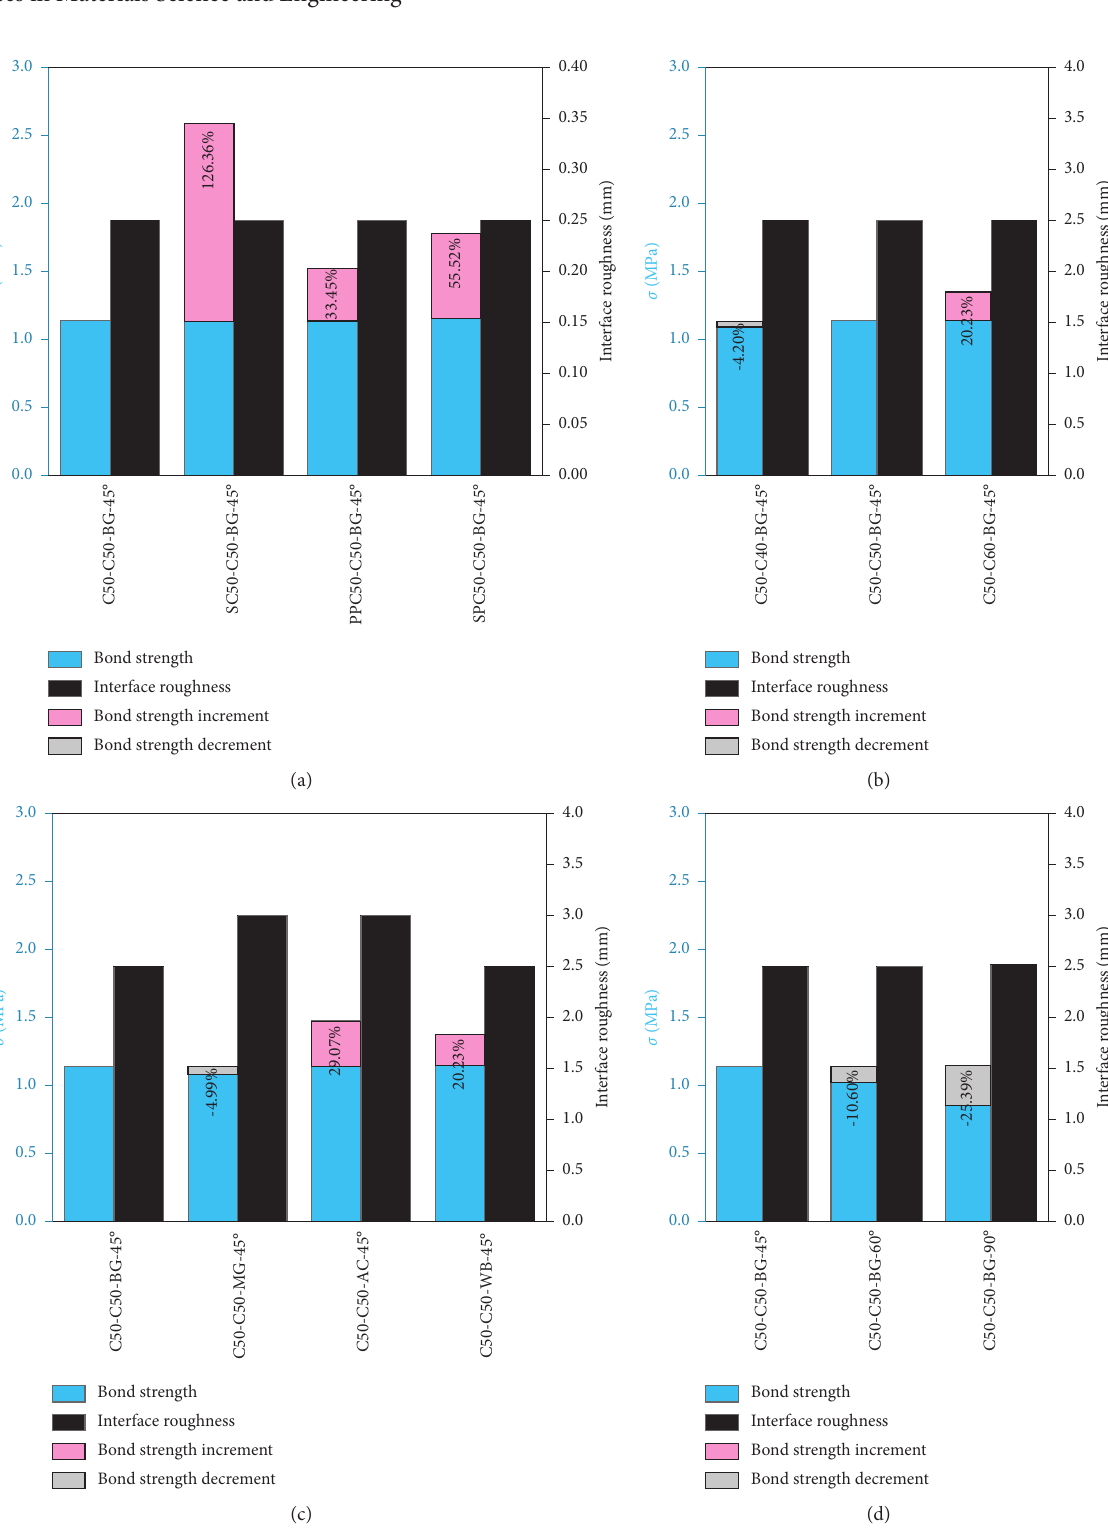
Figure 6: Axial tensile bond strength between the new and old concrete. (a) Fiber type. (b) Concrete strength grade. (c) Surface treatment type. (d) Interfacial